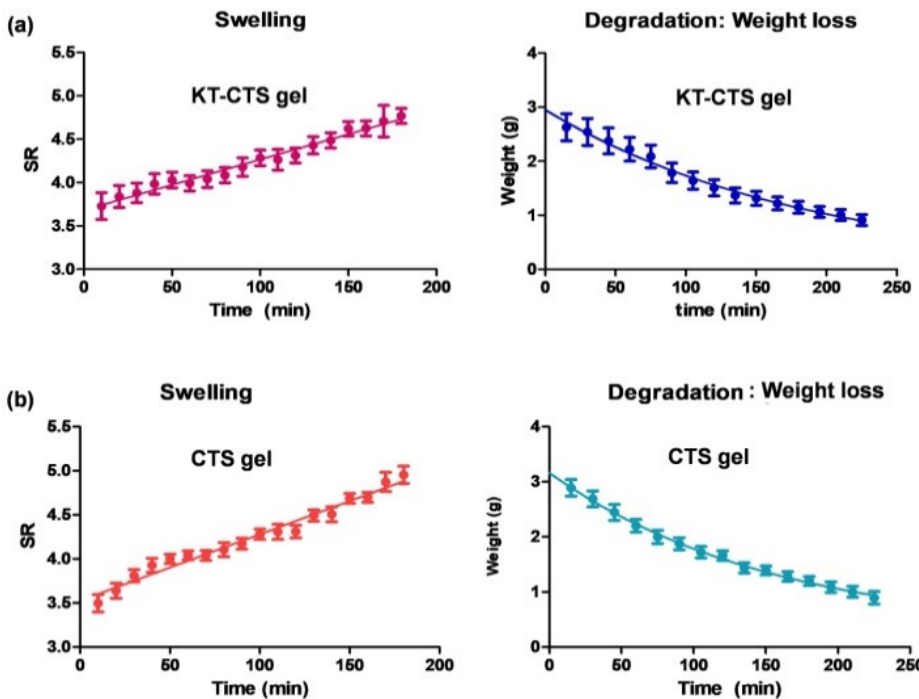
Figure 1. Swelling and degradation processes of KT-CTS gel. Modelling graphic expressed as mean ± SD ( n = 3). Panel ( a ) shows the KT-CTS gel; and panel ( b ) the blank gel without KT (CTS gel). After 3.75 h ± 0.22 h, the CTS gel had utterly degraded in the medium (PBS). The weight loss fitted to a one-phase exponential decay. Table 1 shows the fitted parameters values for both processes. Table 1. Best-fit values of the swelling and degradation processes of CTS gel with and without